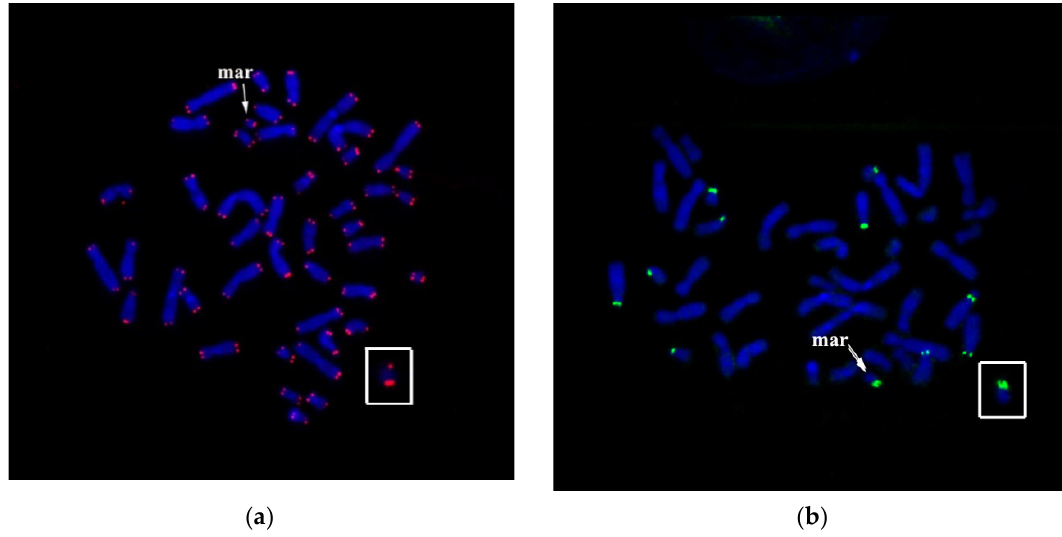
Figure 11. FISH with Tel-DNA probe ( a ) and rDNA-probe ( b ) on the patient’s metaphase chromosomes. mar and arrows indicate sSMC.